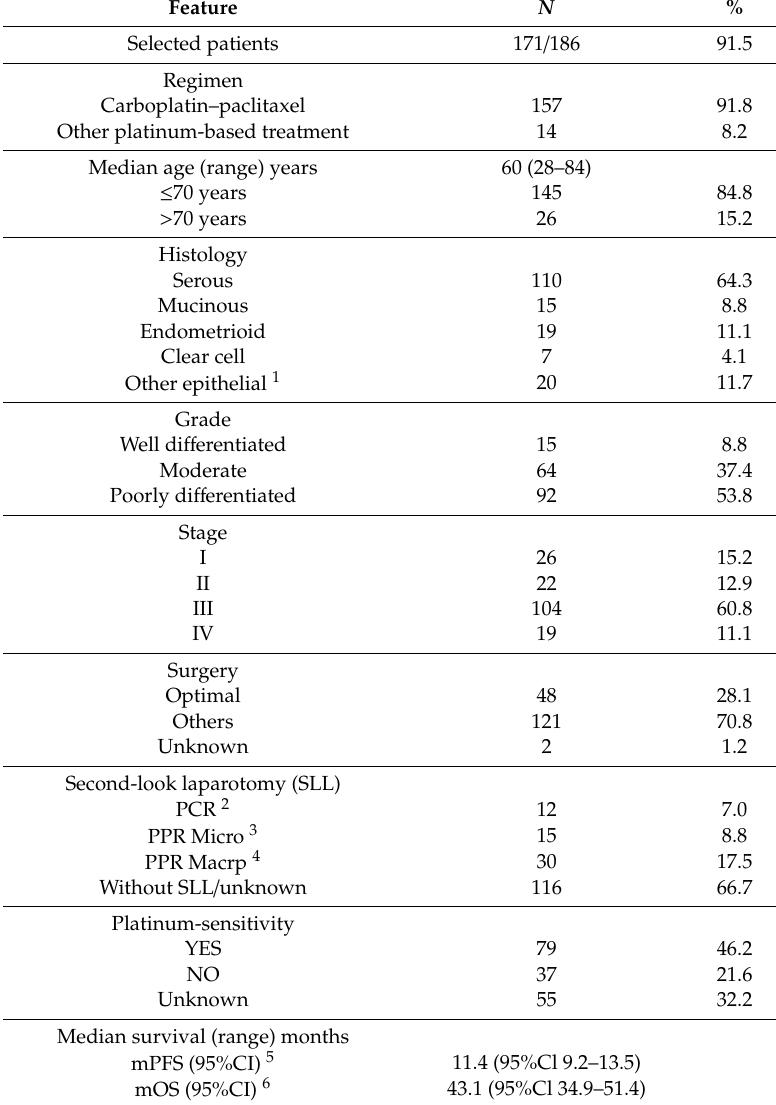
Table 1. Patients’ and tumors’